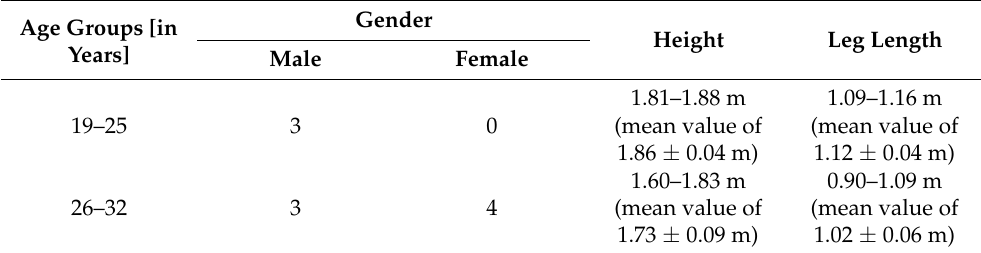
Table 1. Demographic information of